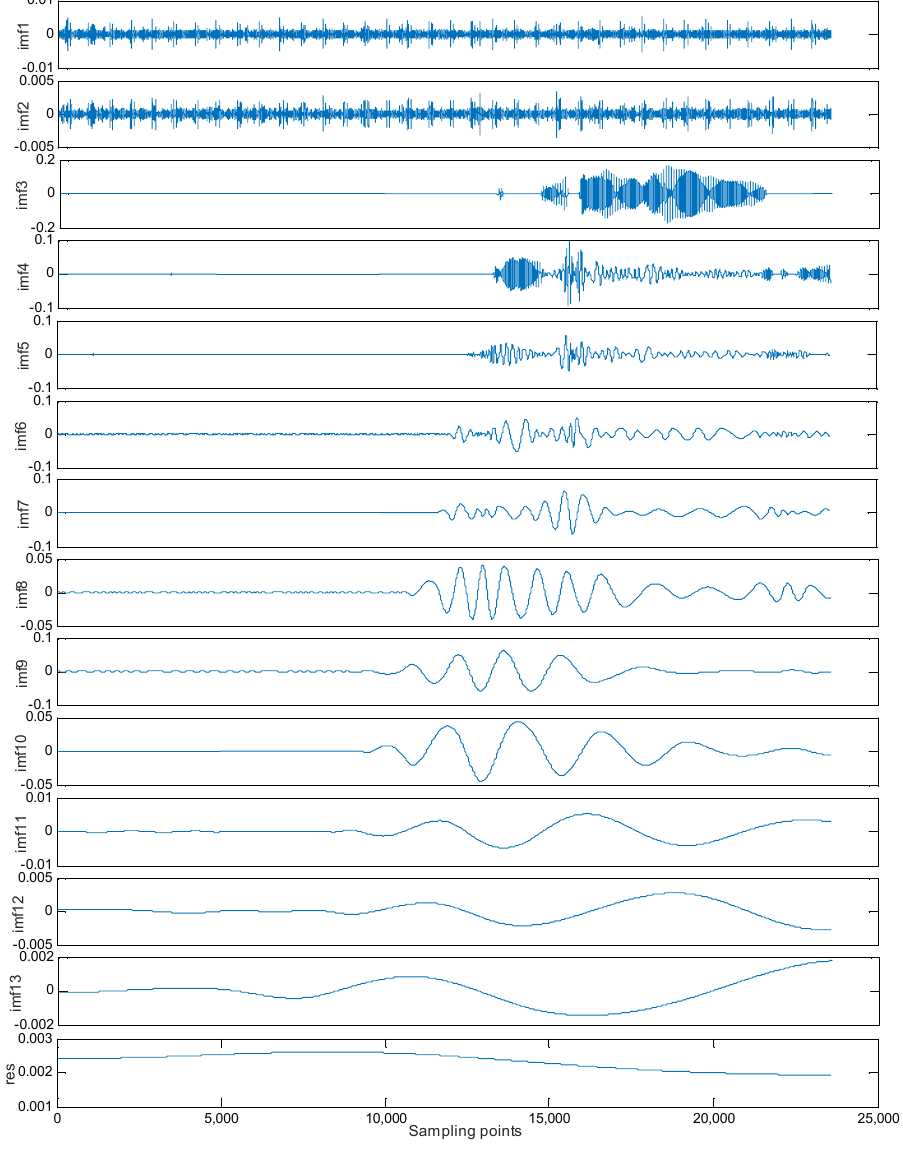
Figure 6. EMD decomposition of the original signal.